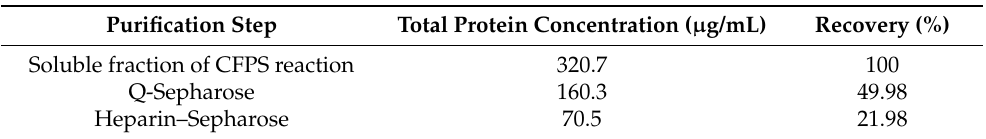
Figure 8. Two-step chromatographic purification of cell-free synthesized human TNF- α protein. ( A ) SDS-PAGE examination of the purification steps of cell-free synthesized human TNF- α protein. Lane M: a prestained protein marker (10–315 kDa), lane 1: the soluble protein fraction of CFPS reaction of human TNF- α , lane 2: sample from peak 17 in the elution profile and lane 3: pooled elution fraction of second purification step using heparin-Sepharose 6 fast flow affinity column. ( B ) SDS-PAGE examination of the purification steps of cell-free synthesized human TNF- α protein in reducing (+) and non-reducing ( − ) conditions. Lane M: a prestained protein marker (10–315 kDa), lanes 1 and 4: the soluble protein fraction of CFPS reaction of human TNF- α , lane 2: negative control reaction, lanes 3 and 5: sample from peak 17 in the elution profile and lanes 6 and 7: pooled elution fraction of second purification step using heparin-Sepharose 6 fast flow affinity column. ( C ) Chromatographic (elution) profile for purifying human TNF- α protein by ion exchange chromatography column packed with Q-Sepharose fast flow resin. Table 3. Purification of cell-free synthesized human TNF- α protein by the two-step chromato- graphic strategy.